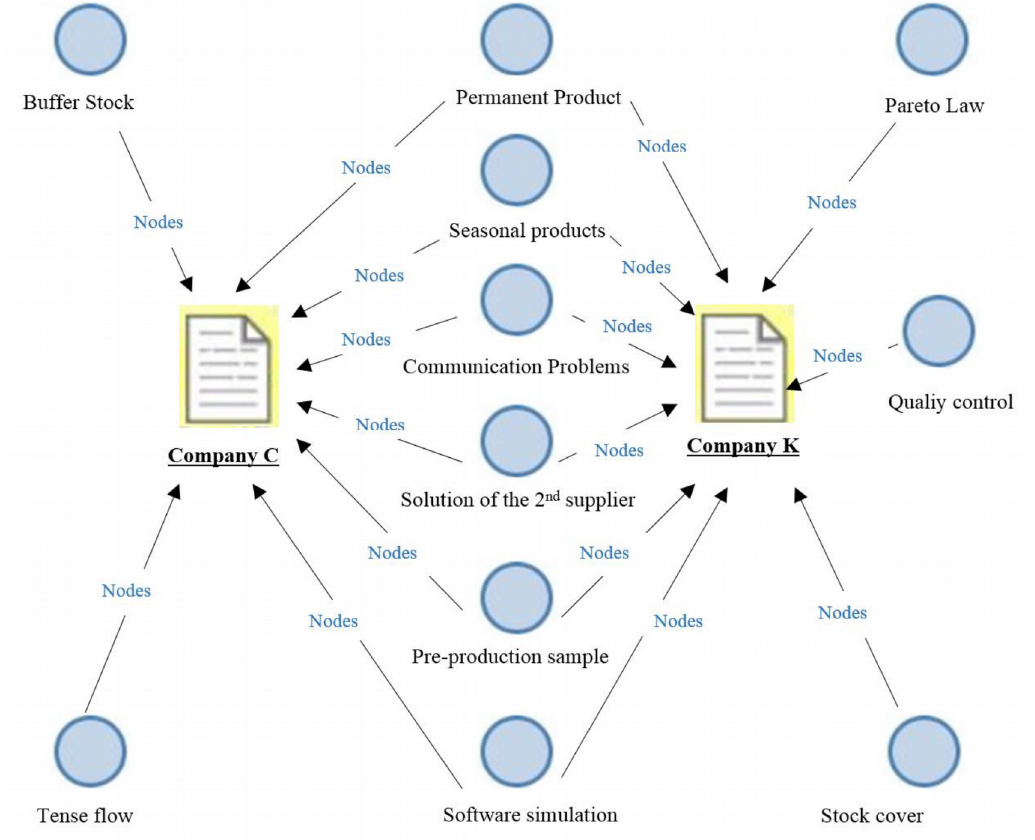
Figure 2. Comparison between company C and K by